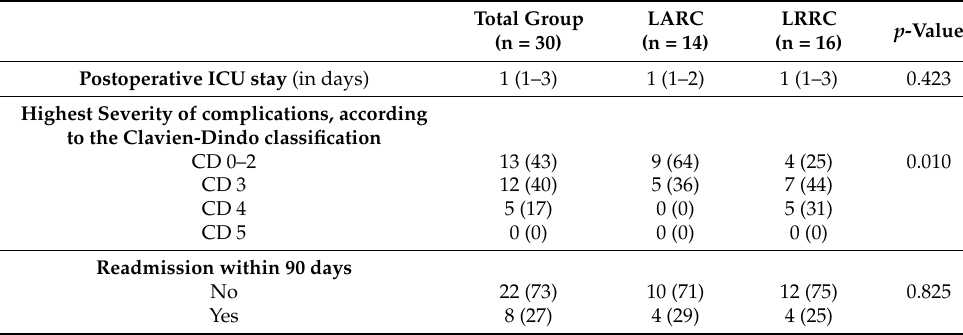
Table 3. Outcome measures of safety.